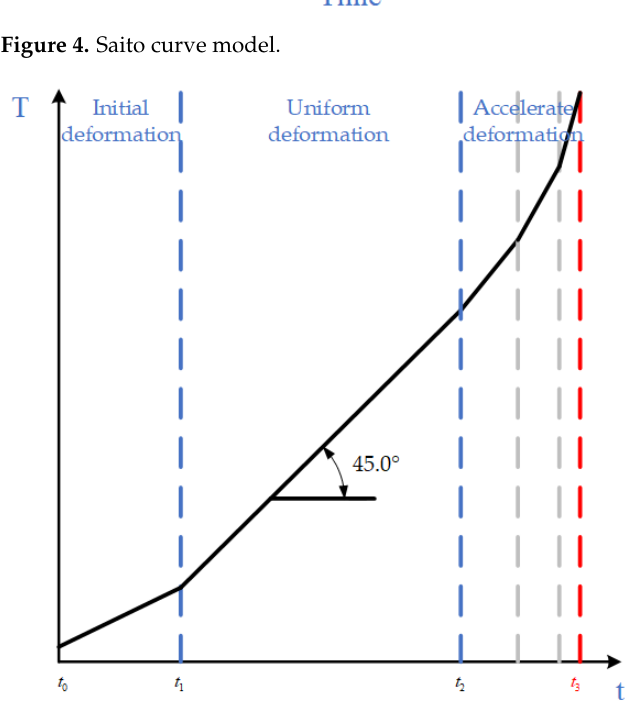
Figure 5. Tangent angle